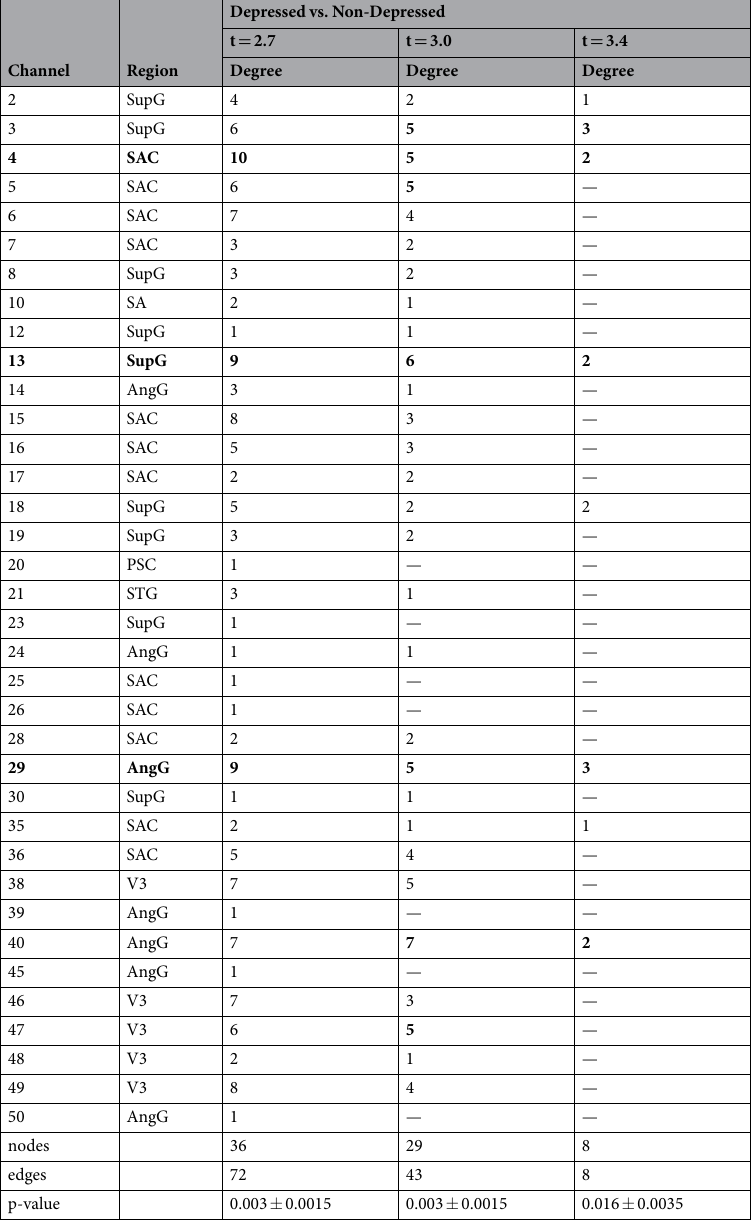
Table 2. Degrees of the significant network differences between Depressed and Non-Depressed subjects at t (82) = 2.7, t (82) = 3.0 and t (82) = 3.4. Only channels of the significant network are presented. SAC = somatosensory association cortex, SupG = supramarginal gyrus, AngG = angular gyrus, STG = superior temporal gyrus, FusG = fusiform gyrus, MTG = middle temporal gyrus, PSC = primary somatosensory cortex, SC = subcentral area. Bold numbers are hub